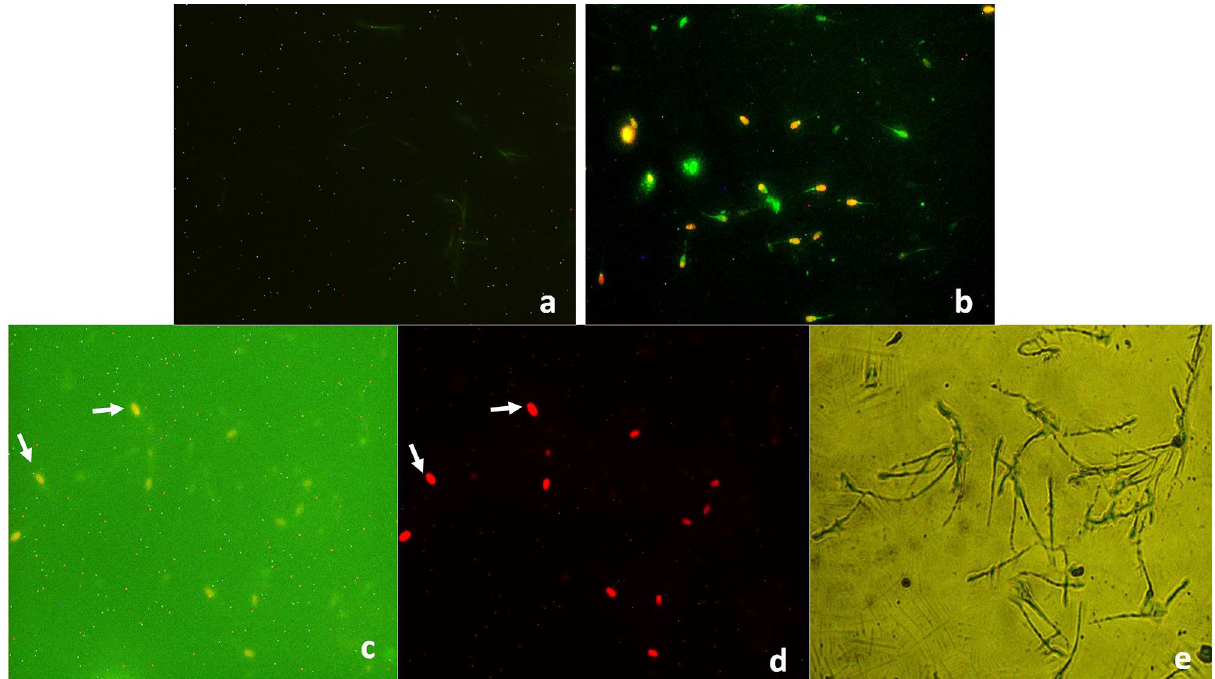
.Figure 15 Table 6. Correlation between necrosis, apoptosis and DNA damage of different concentrations of mercuric chloride (0.031–1.25 µg/ml) at different time intervals (*p ≤ 0.05).